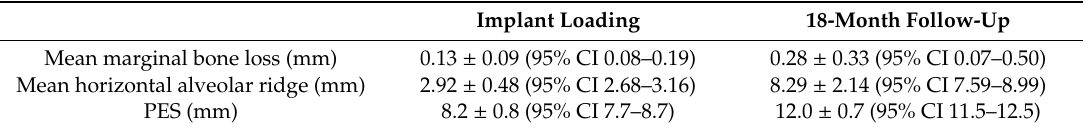
Table 2. Implant